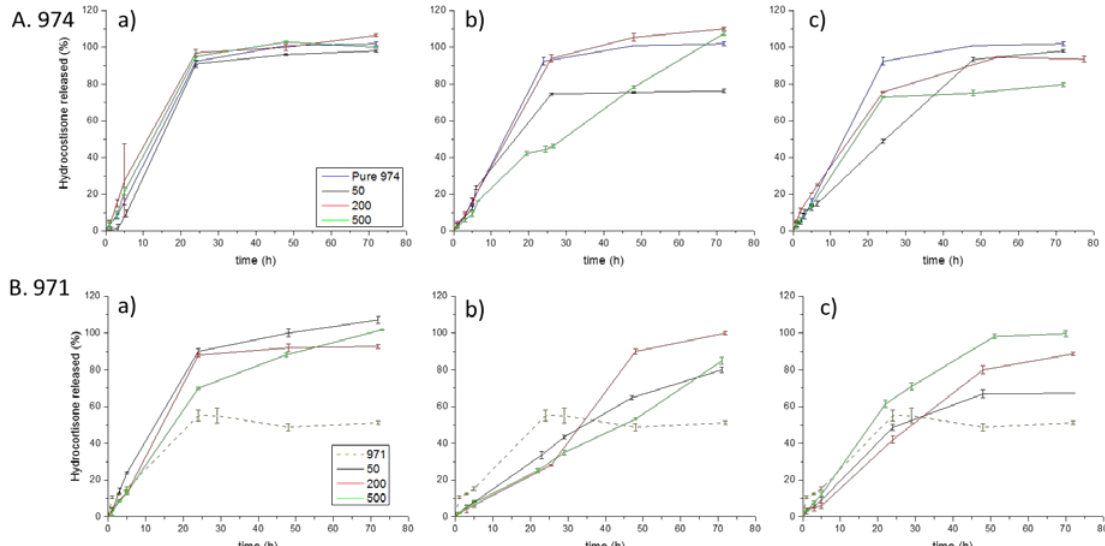
Figure 6. Release profiles of hydrocortisone from the tablets composed of poly(2-ethyl-2-oxazoline)s/Carbopols in simulated saliva at 37 °C: ( a ) physical mixture; ( b ) interpolymer complexes formed in water; and ( c ) interpolymer complexes formed at pH 2. (A Carbopol 974; and B. Carbopol 971).